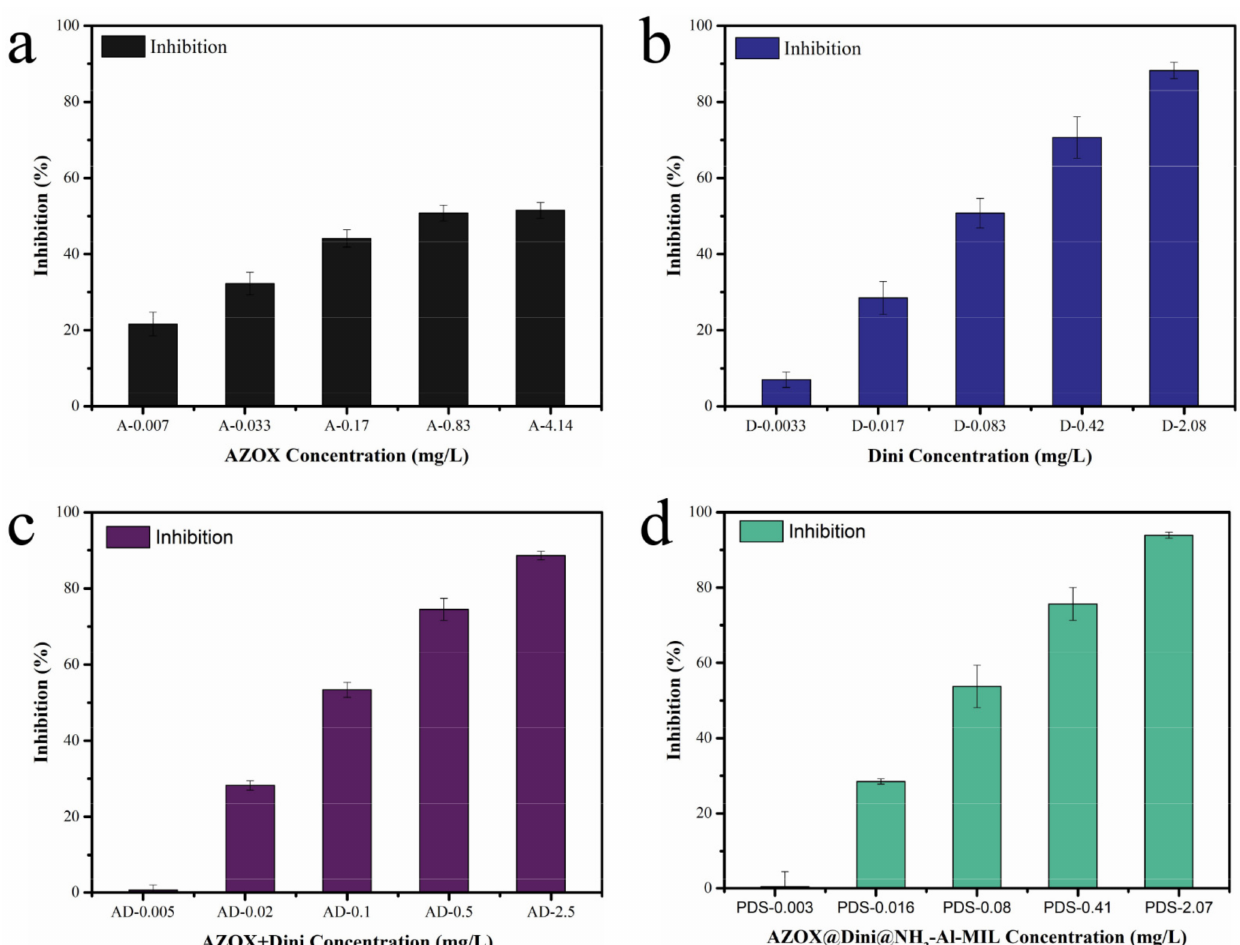
Figure 9. Inhibition of rice sheath blight in pure AZOX ( a ), pure Dini ( b ), AZOX + Dini ( c ), and AZOX@Dini@NH 2 -Al-MIL- 101 ( d ) at 25 ± 2 ◦ C. The error bars represent standard deviation of the mean. Table 4. Calculated EC 50 of pure AZOX, pure Dini, physical mixture of AZOX and Dini (AD)